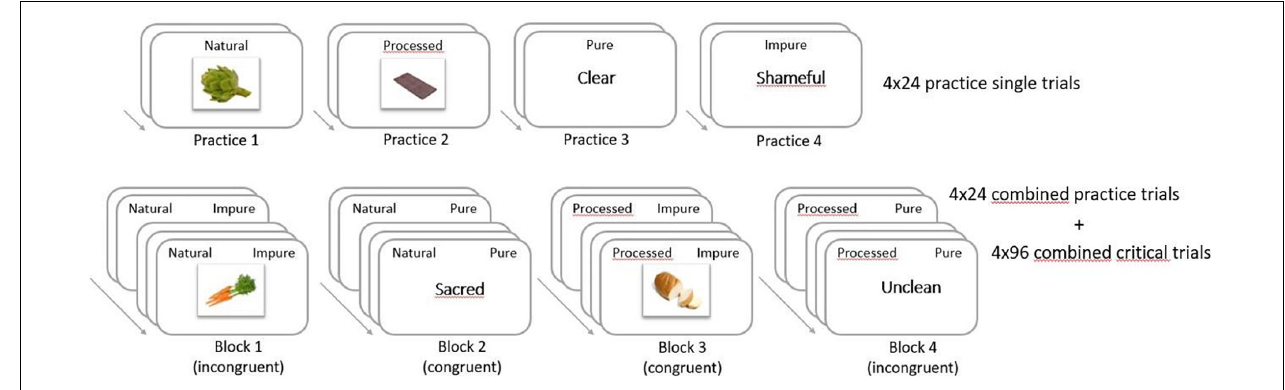
FIGURE 1 | Design of the Go/No-Go Association Task to determine the strength of association between processed versus natural foods and morally “pure” versus “impure” attributes. In this study, the GNAT was administrated in French. For the purpose of this paper, this figure is an English translation of the task.